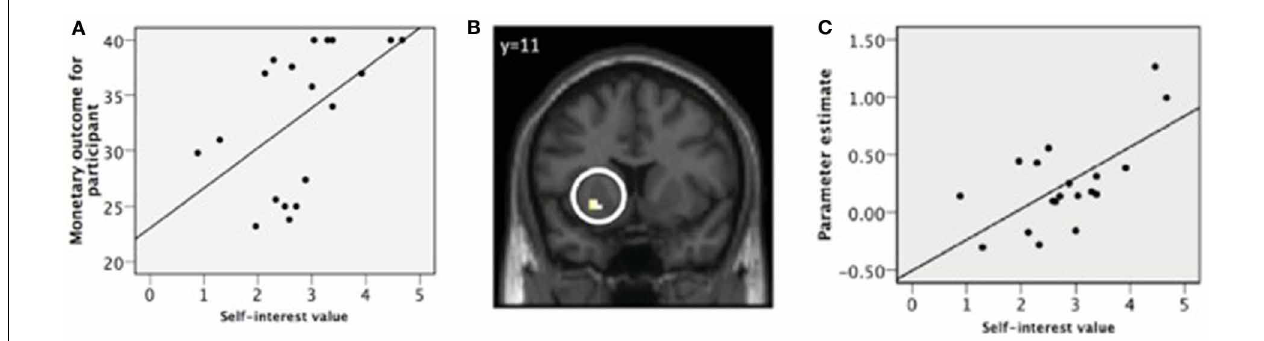
FIGURE 2 | Impact of self-centered core value hierarchies on neural regions representing economic value and on charitable behavior. (A) Participants with a self-centered core value hierarchy kept more money for themselves instead of donating it to charity. (B) The same participants